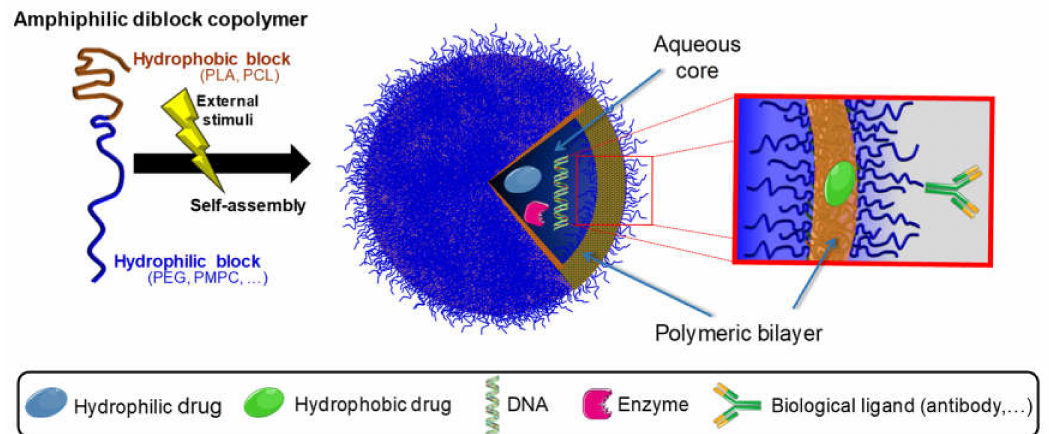
Figure 3. Schematic representation of the formation of a polymersome and its versatile properties. Polymersomes are generally self-assembled from block copolymers, presenting a unique structure that is able to encapsulate di ff erent biological